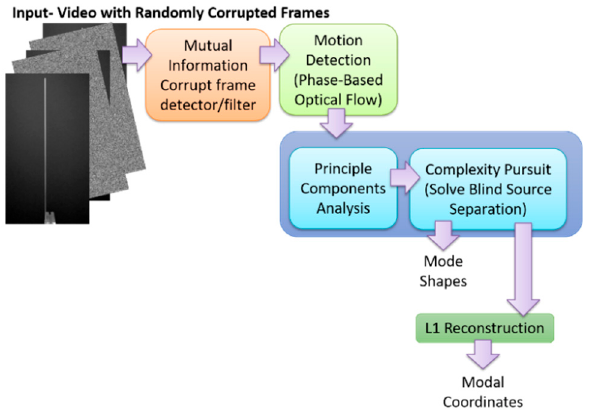
Figure 21. Algorithm for recovering mode shapes from video with randomly corrupted frames without using L1 regularization. L1 regularization is only used to recover the modal coordinates.